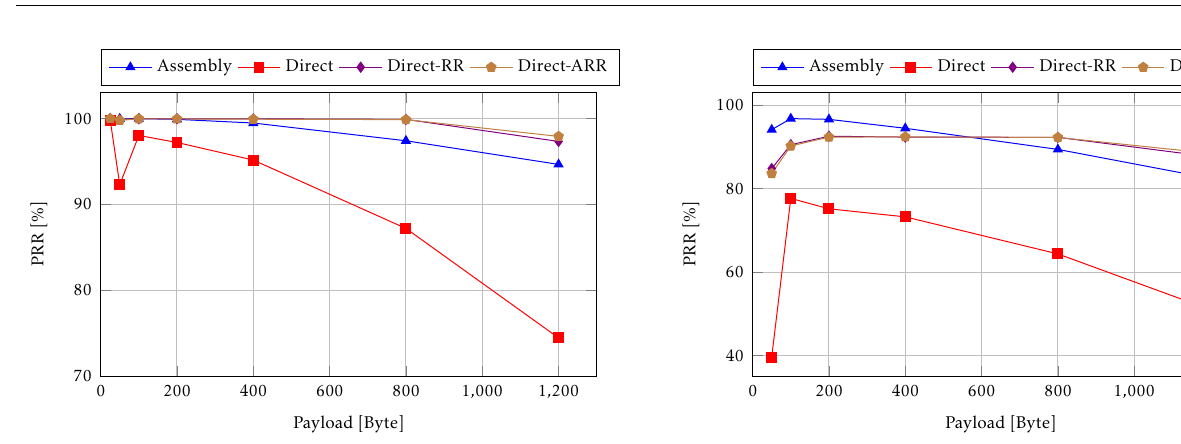
Figure 3. PRR of the Chain Network 37 . 5 B/s ; first set of experiments